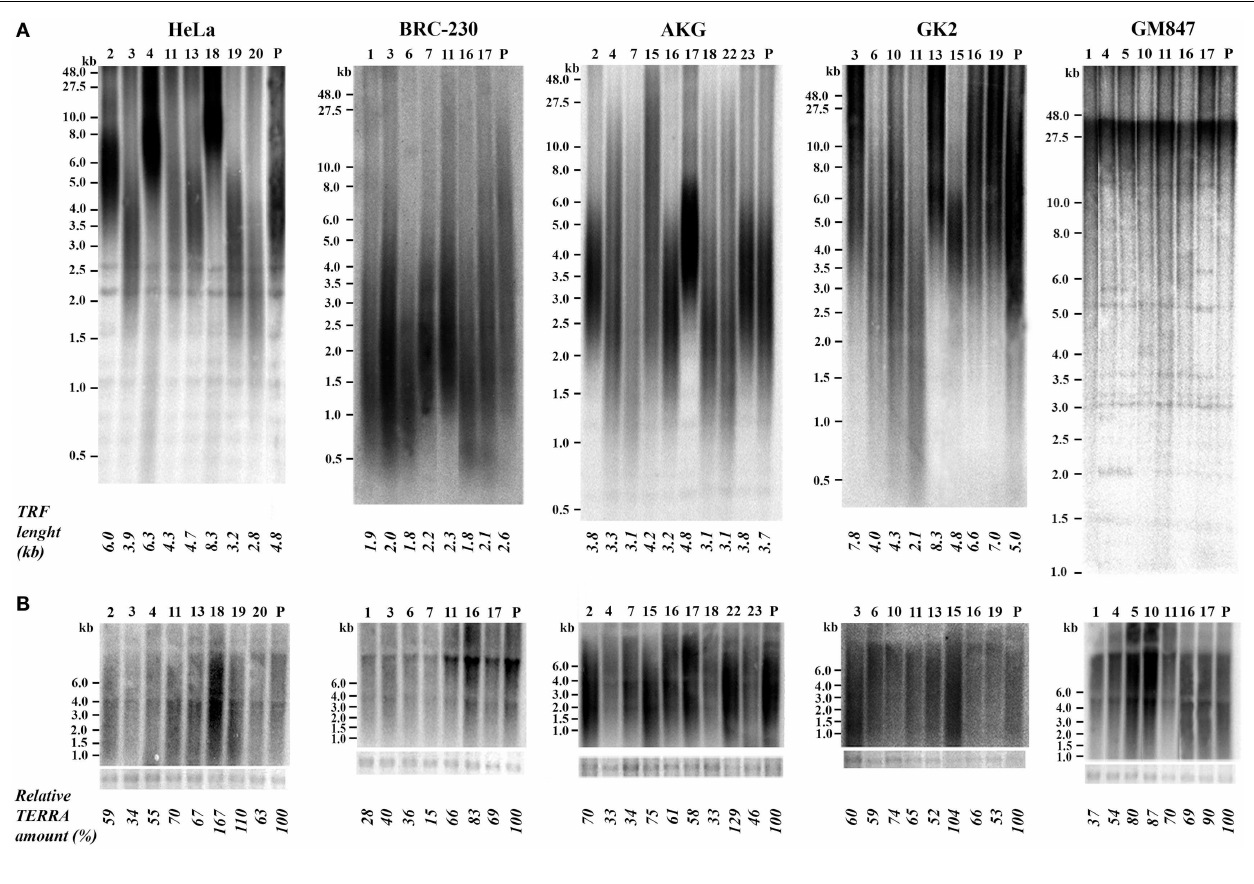
TERRA expression detection by northern blotting in the same parental cell lines and in the clones. Ethidium bromide-stained 18S rRNA bands (bottom) were used as loading